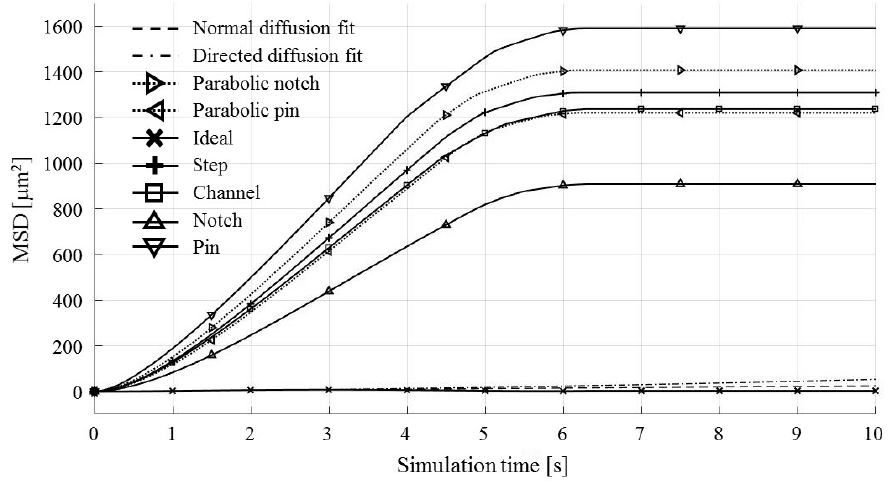
Figure 18. MSD curves for test particles 1–7 (left third).